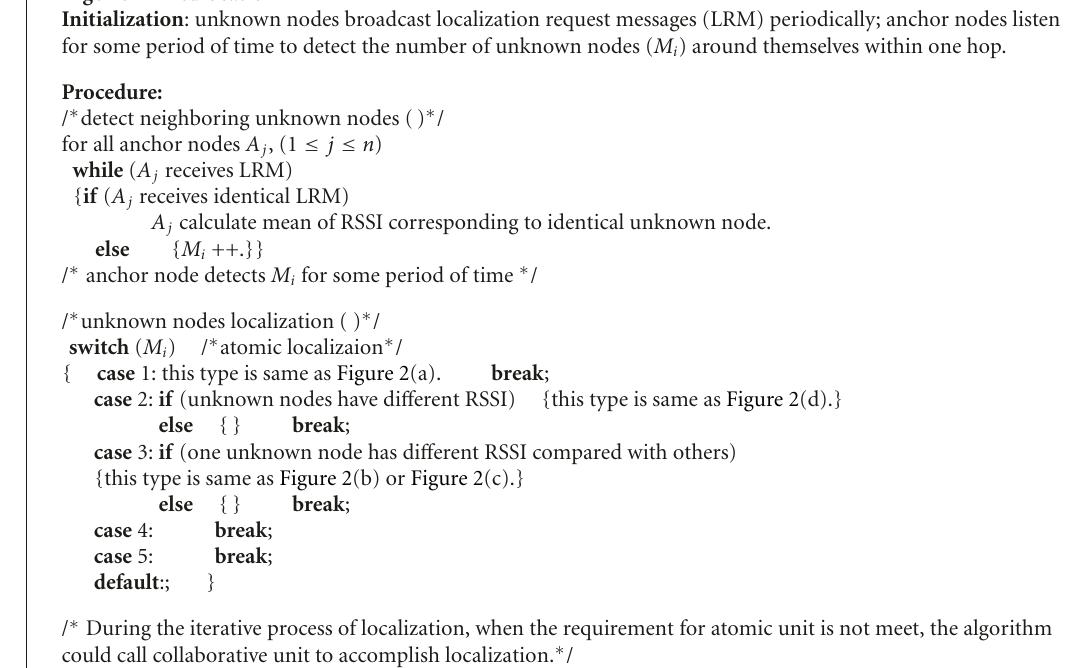
Algorithm 1: Flowchart of Kcdlocation